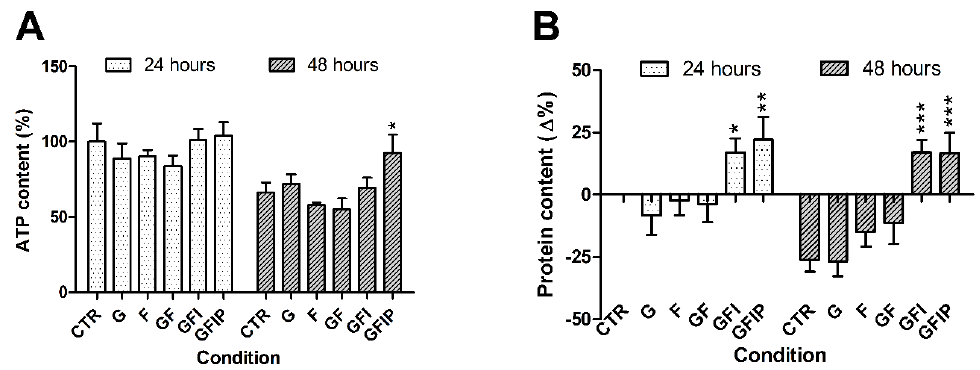
Figure 1. ( A ) ATP content of precision-cut liver slices (PCLSs) after 24 and 48 h. Data is presented as mean percentage of 24 h control ± SEM ( n = 5). Using a one-way ANOVA, all conditions were compared to the relative control. * p < 0.05 ( B ) Difference in protein content after 24 and 48 h. Data is expressed as mean difference as compared to the 24 h control ± SEM ( N = 5). Significance was determined using a one-way ANOVA, comparing all conditions from a time point to the control of that time point. * p < 0.05, ** p < 0.01, *** p < 0.001. CTR = control, G = Glucose, F = Fructose, GF = Glucose and fructose, GFI = Glucose, fructose, and insulin, GFIP = Glucose, fructose, insulin, and palmitic acid.